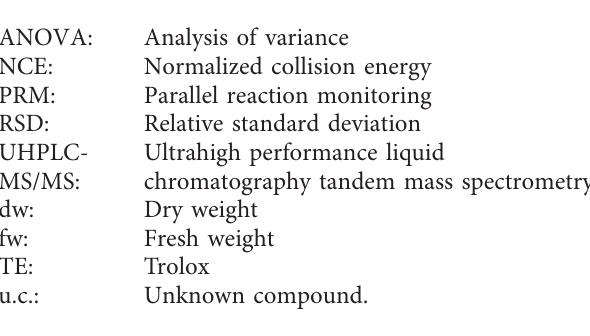
Supplementary Figure 1: analysis of phenolic compounds in Salacca zalacca fruit pulp by UHPLC-HRMS/MS with